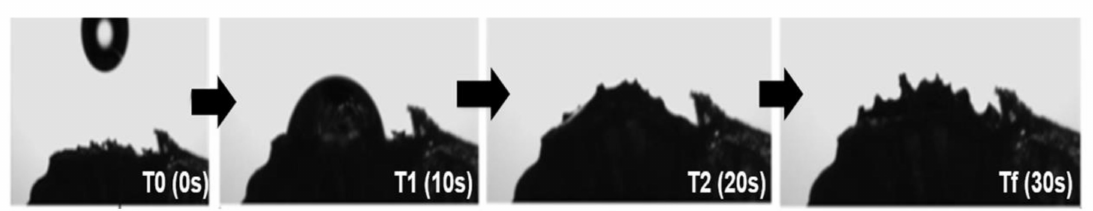
Figure 5. Hydrogel swelling process (images from goniometer assay using Xanthan-Chitosan hydrogels and distilled water). Source: Batista et al. (2019) with permission [18].